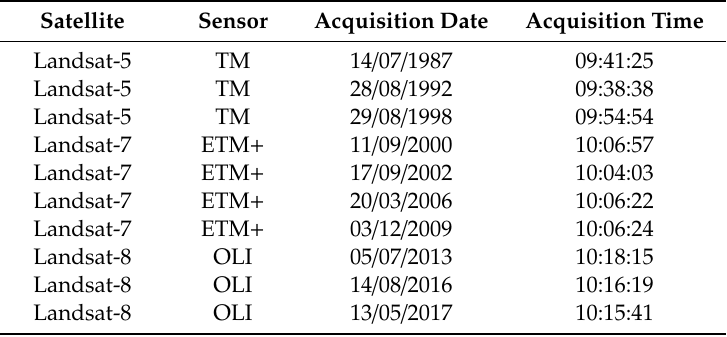
Table 1. Landsat images used in the present